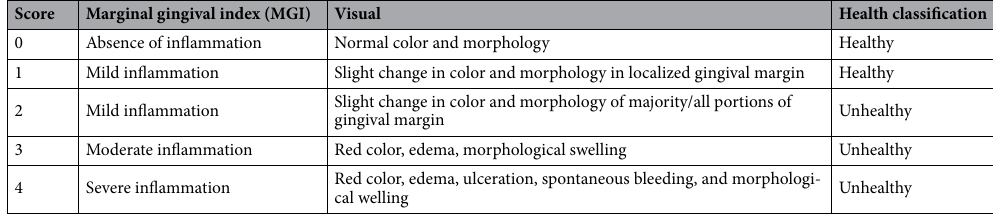
Table 2. Description of the modified gingival index scoring